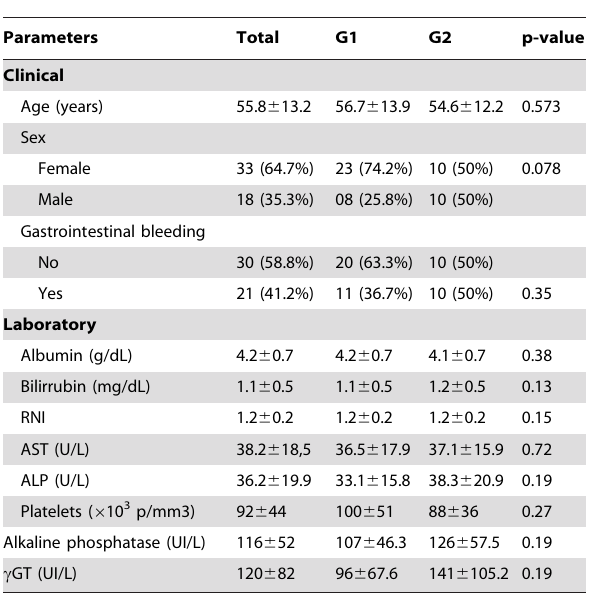
Table 1. Clinical and laboratory parameters.